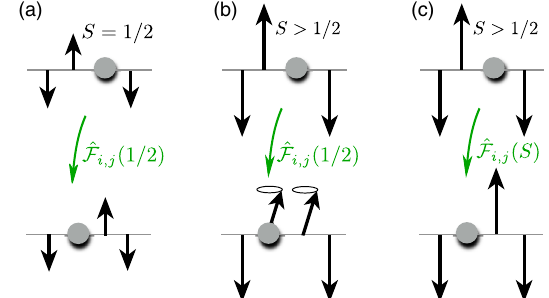
FIG. 24. Illustration of hole hopping in a large- S spin envi- ronment along one direction. (a) For S ¼ 1 /2, the hole distorts the N´eel order of the AFM spin environment. (b) For large S > 1 /2, but using the spin- 1 /2 hole hopping operator order parameter is not distorted but spin excitations (magnons) are created on top of the AFM by the movement of the hole. (c) For large S , the hole hopping described by the spin states on neighboring sites and fully captures the distortion of the N´eel order around the